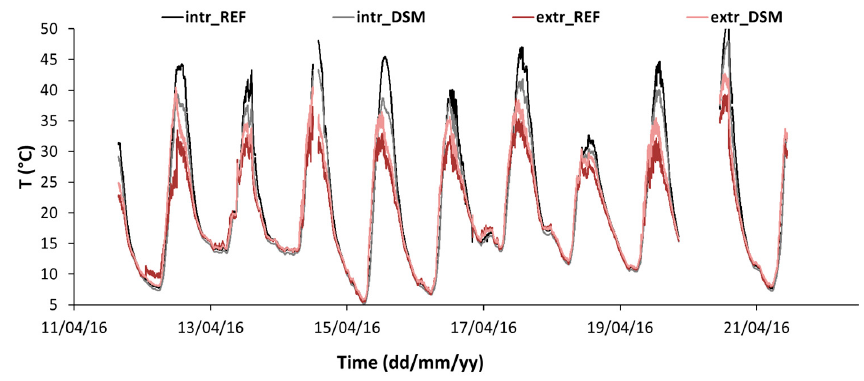
Figure 8. Temperature trends of intrados and extrados of REF and DSM box during the period of test.